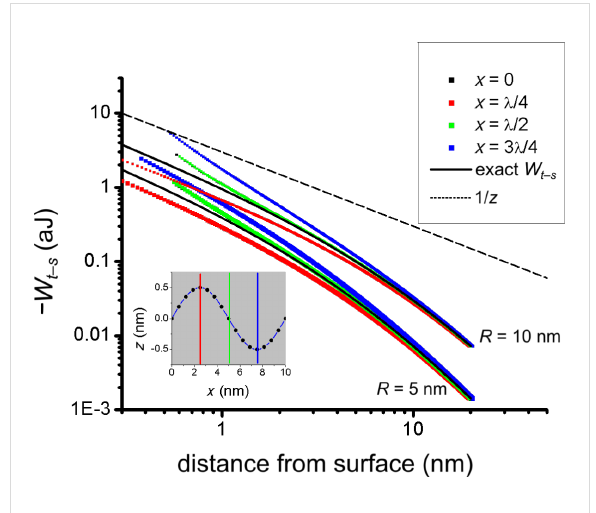
Figure 5: Hamaker force law for corrugated surfaces: Tip–sample dis- tance dependence of tip potential for high-symmetry points (inset, x = 0, x = λ /4, x = λ /2, and x = 3 λ /4) for the two radii ( R = 5 nm and R = 10 nm); for x = 0 and x = λ /2 the curves overlap. Lines for the exact analytical form (Equation 10) of the Hamaker relationship between a sphere and a plane are shown (black line) for